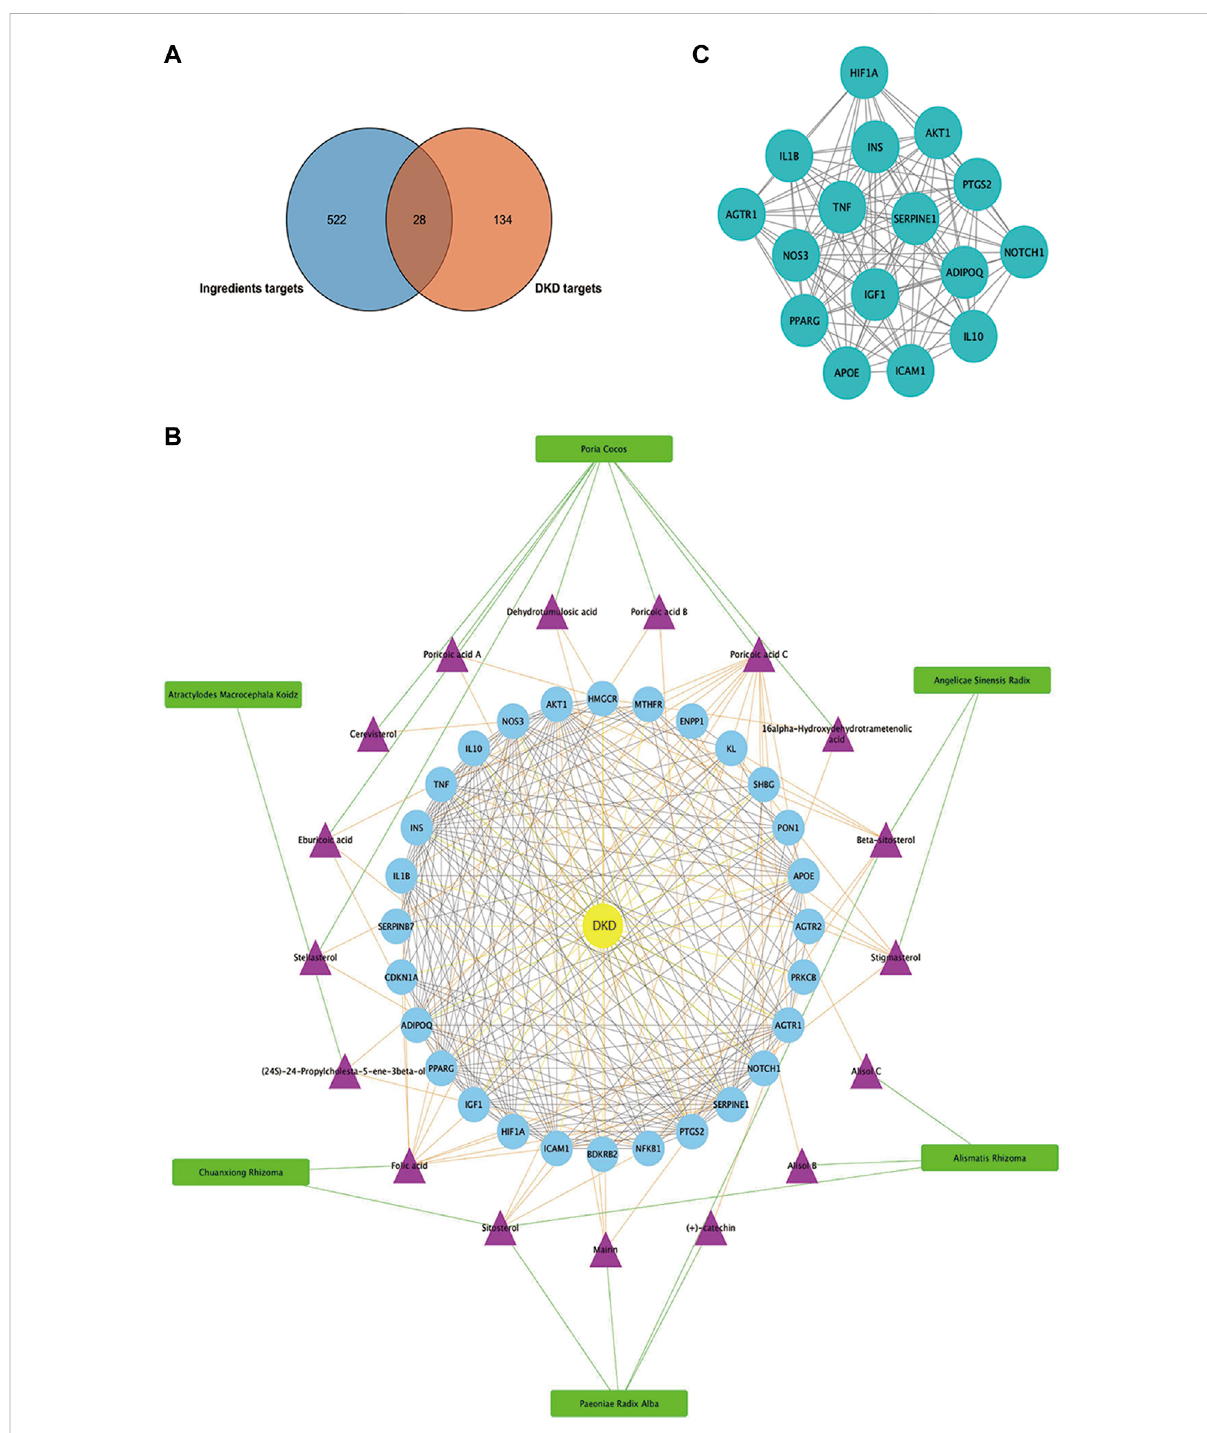
FIGURE 6 Matching of target genes between DKD and DSS, and network analysis of the common targets. (A) Venn diagram composed of the ingredients targets and DKD targets. (B) Herbs-active ingredients-common targets-Disease network. The green rectangles represent herbs of DSS, the purple triangles represent screened active ingredients of these herbs, and the blue circles represent the common targets of DSS and DKD. The green lines representtheinteractionsbetweenherbsandthechemicalingredients,theorangelinesrepresenttheinteractionsbetweeningredientsandthe common targets, the yellow lines represent interactions between DKD and the common targets, while the protein-protein interactions were represented as prey lines. (C) Protein-protein interaction network constructed of 16 core targets screened by MCODE